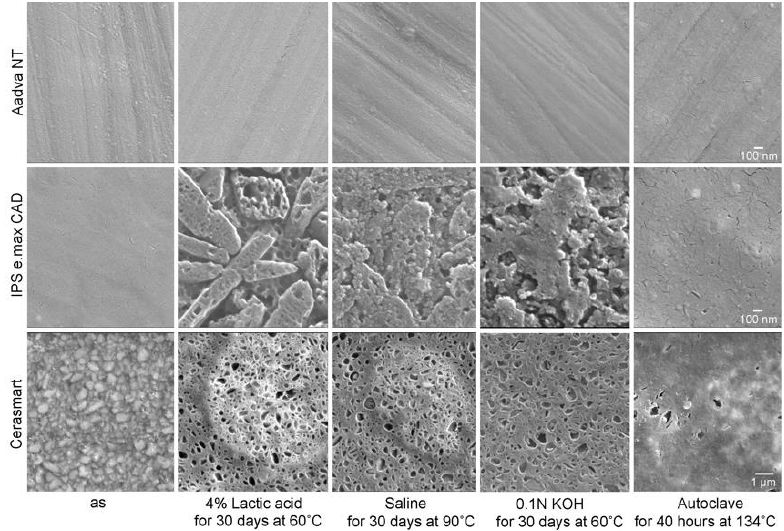
Figure 19. Secondary electron images of high translucent zirconia (5Y) (Aadva NT ® ), lithium disili- cate (IPS e.max CAD ® ), and hybrid resin (Cerasmart ® ) before and after soaking in 4% lactic acid for 30 days at 60 °C, saline solution for 30 days at 90 °C, and 0.1N KOH for 30 days at 60 °C, and after autoclaving for 40 h at 134 °C. Reprinted with permission from Ref. [44]. 2020 Seiji Ban.